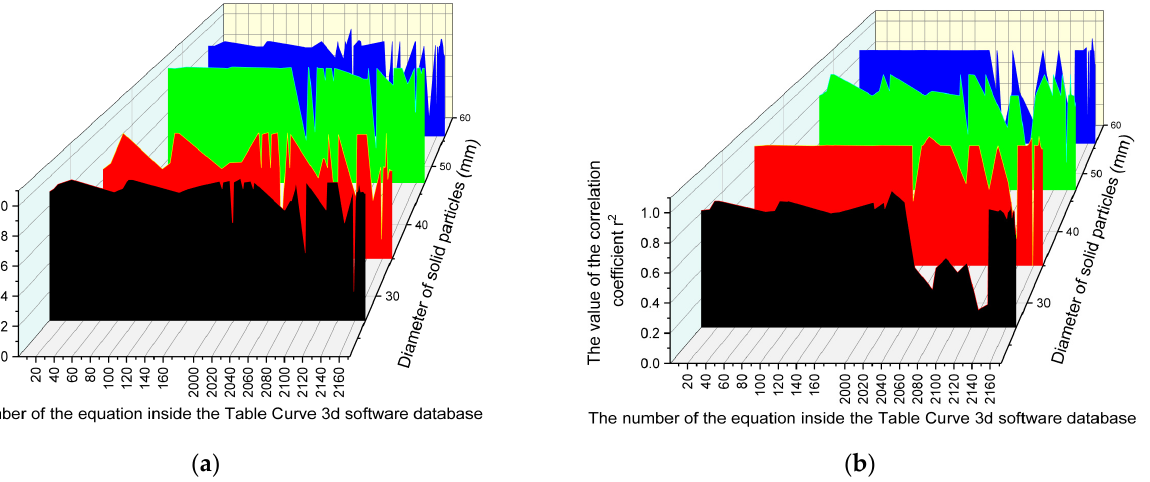
Figure 9. Analysis of common equations based on the value of the correlation coefficient r 2 [43]: ( a ) the average instantaneous velocity; ( b ) the average angular velocity.